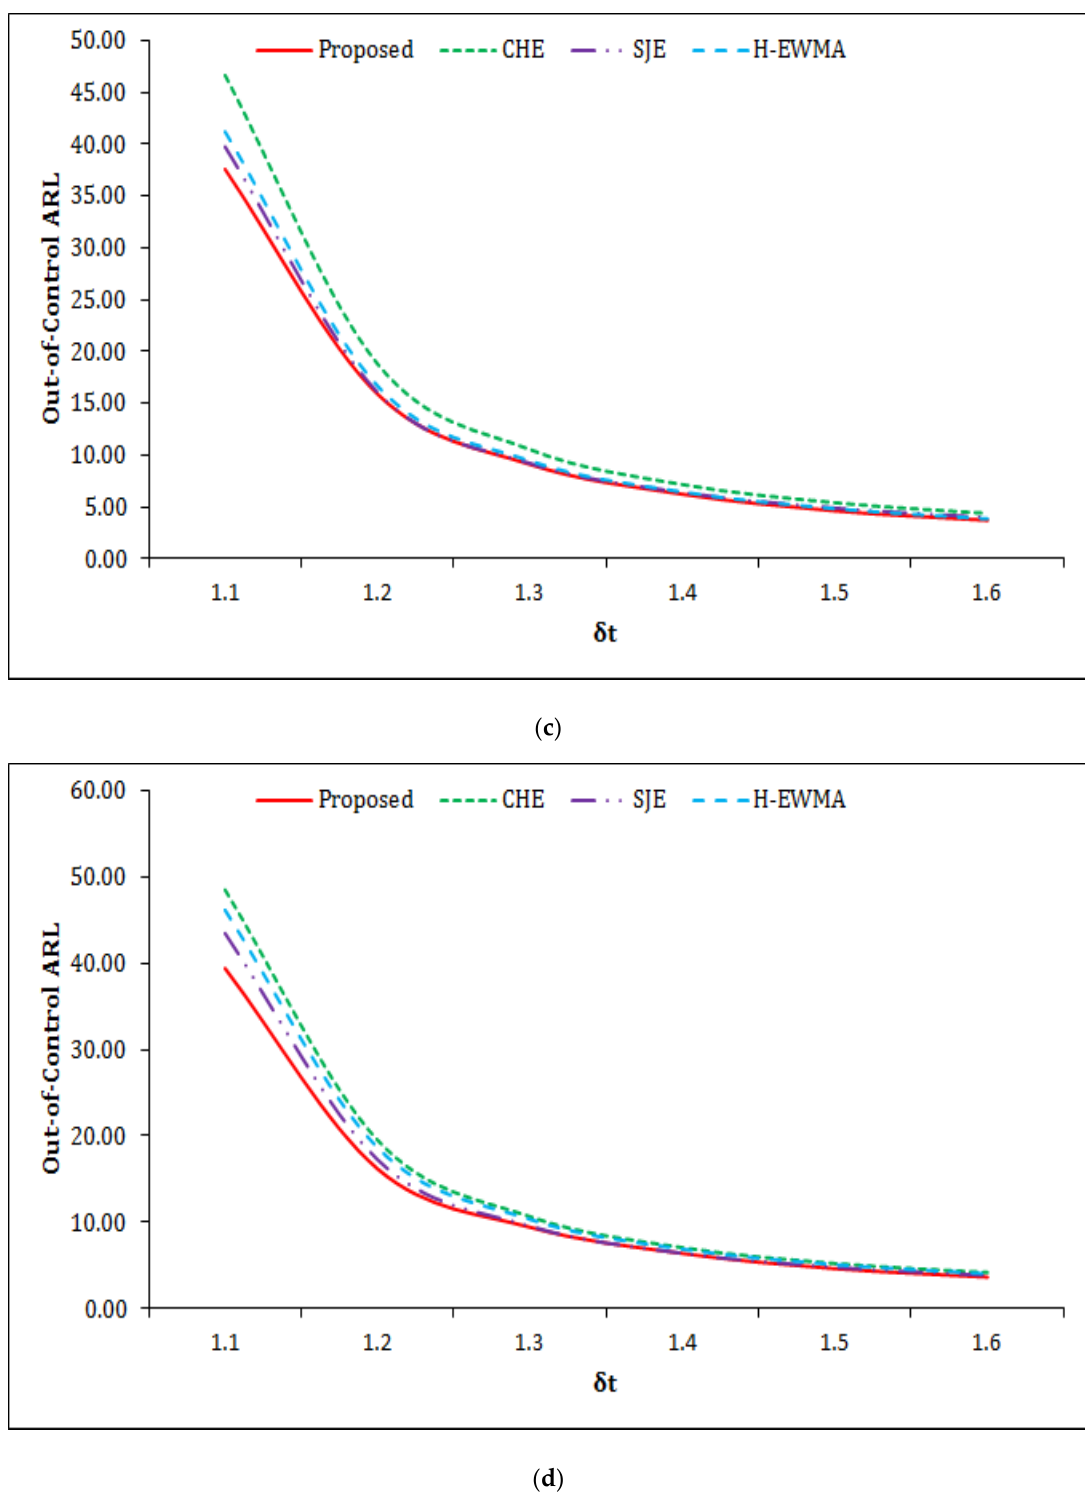
Figure 4. The ARL 1 comparisons between proposed CH-EWMA, SJ-EWMA, and H-EWMA charts when ( a ) 𝜑 = 0.05 , ( b ) 𝜑 = 0.1 , ( c ) 𝜑 = 0.2, and ( d ) 𝜑 = 0.3 .